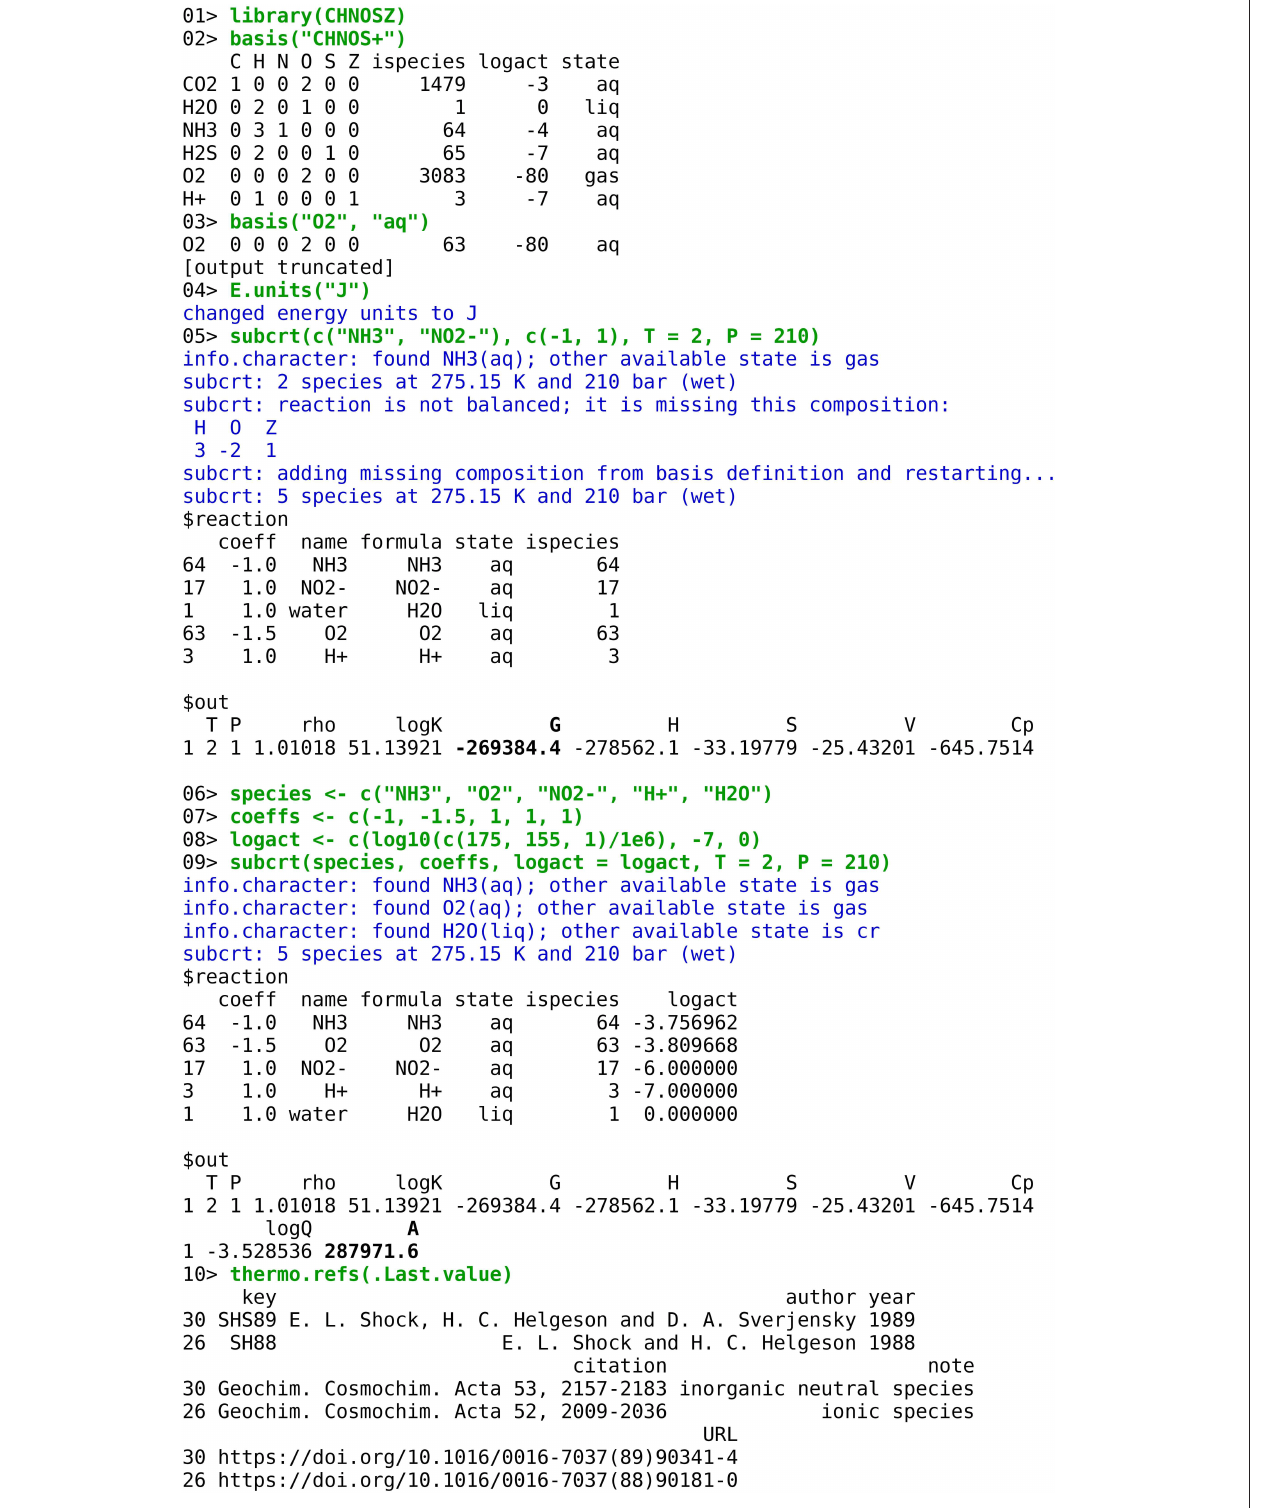
Frontiers in Earth Science |